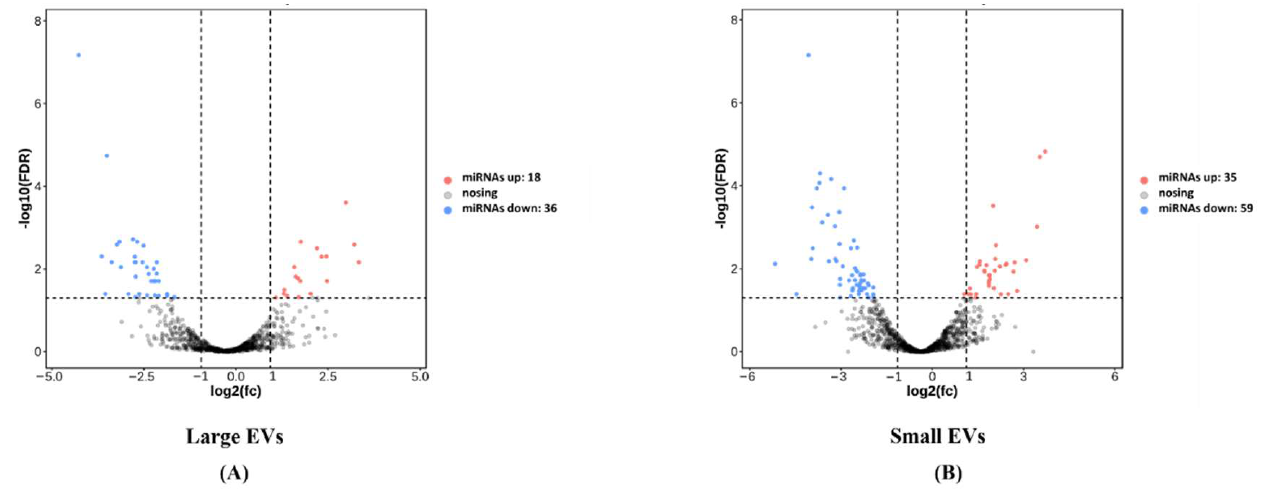
Figure 3. The volcano maps show the numbers of the abundantly expressed miRNAs in placental large EVs ( A ) and small EVs ( B ) derived from missed miscarriage placentae.